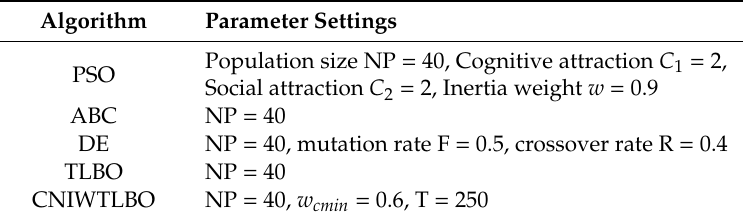
Table 2. Parameter settings for particle swarm optimization (PSO), artificial bee colony (ABC), di ff erential evolution (DE), teaching–learning-based optimization (TLBO) and cyclical non-linear inertia-weighted teaching–learning-based optimization (CNIWTLBO)